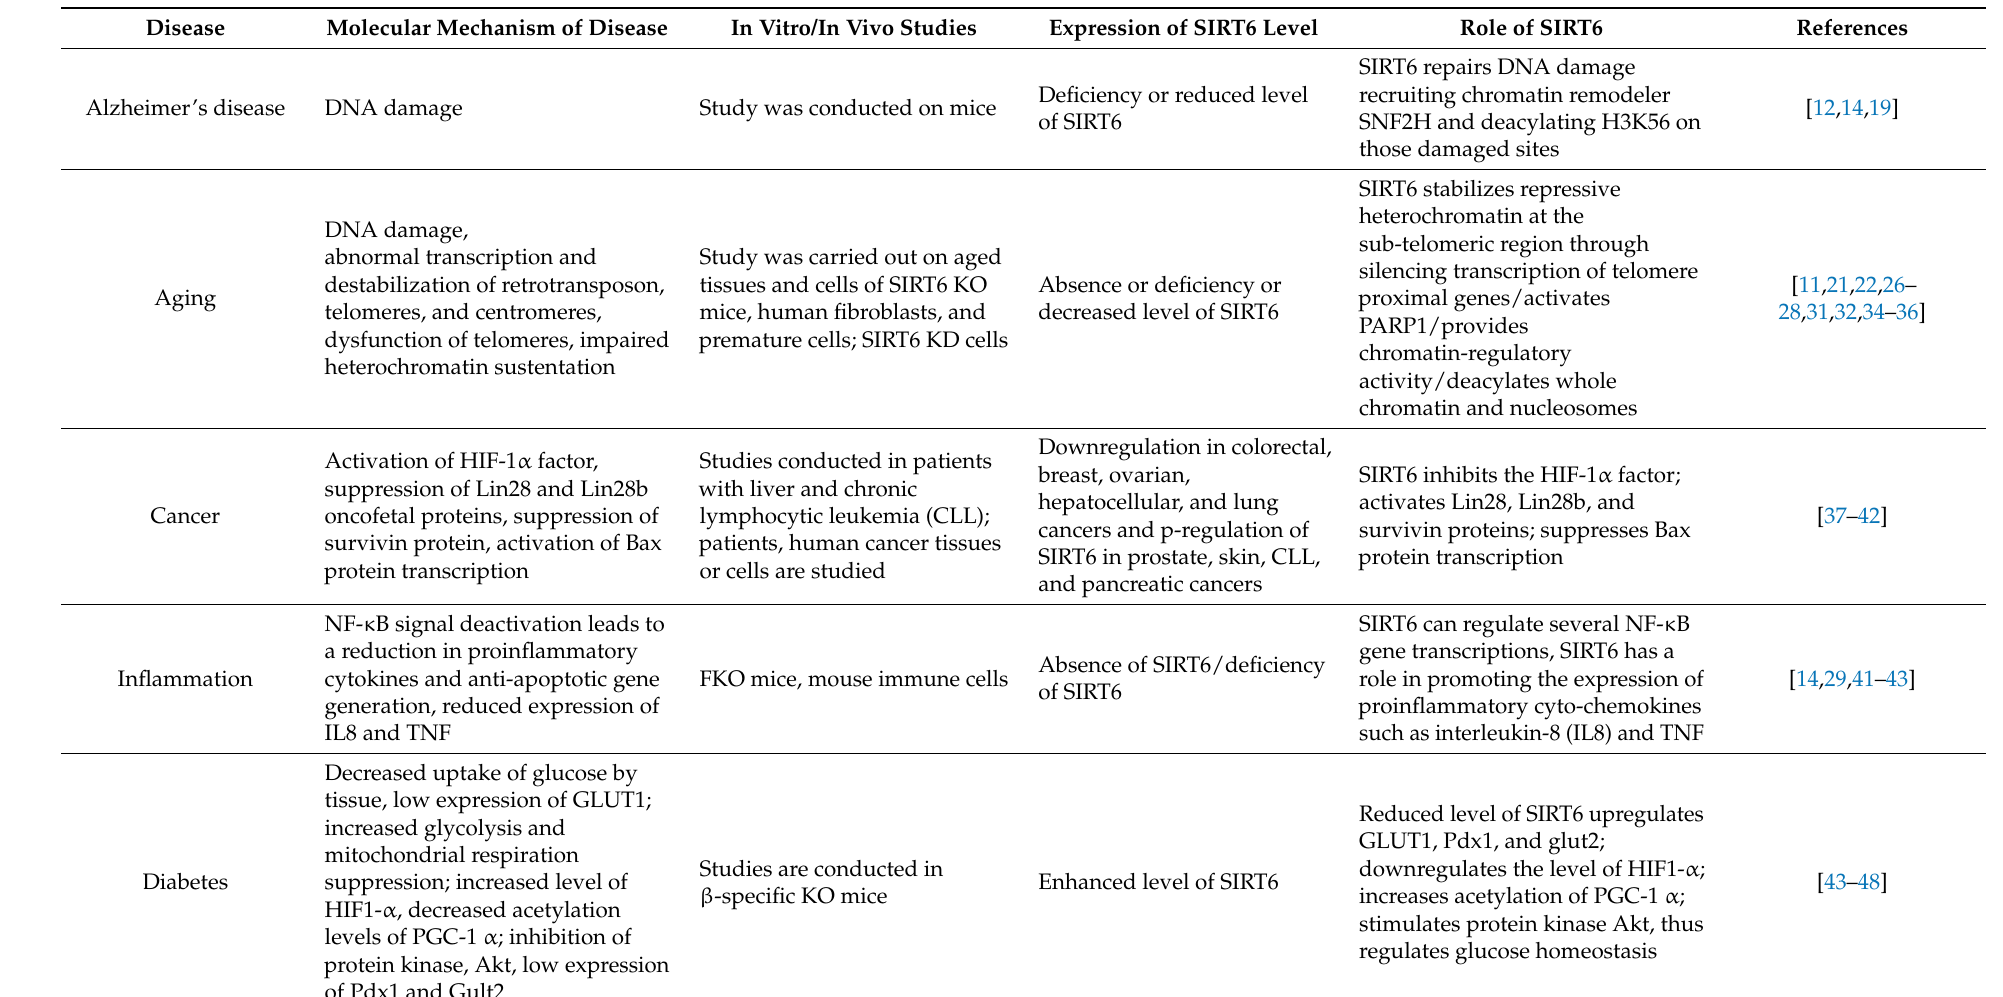
Table 1. Association of SIRT6 with Alzheimer’s disease, aging, cancer, inflammation, and